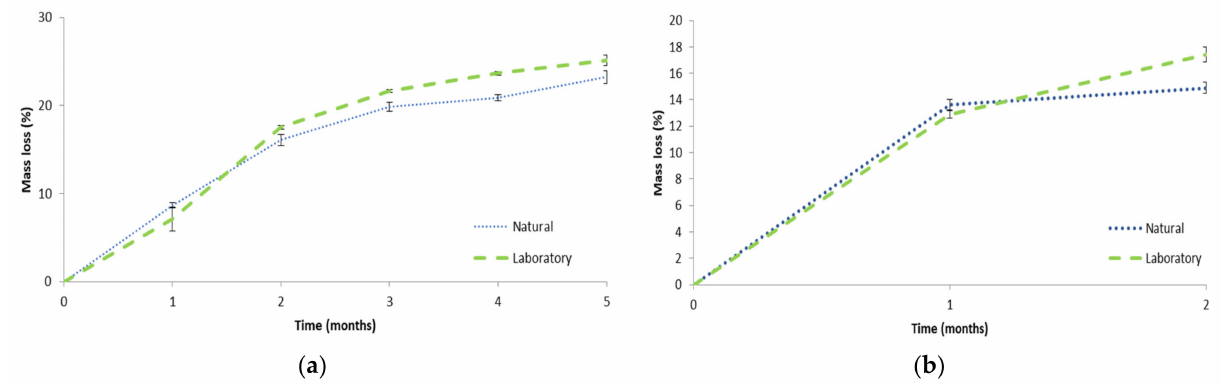
Figure 13. Mass loss of polymeric foam samples in natural and laboratory aerobic biodegradation conditions for ( a ) PF1 and ( b )